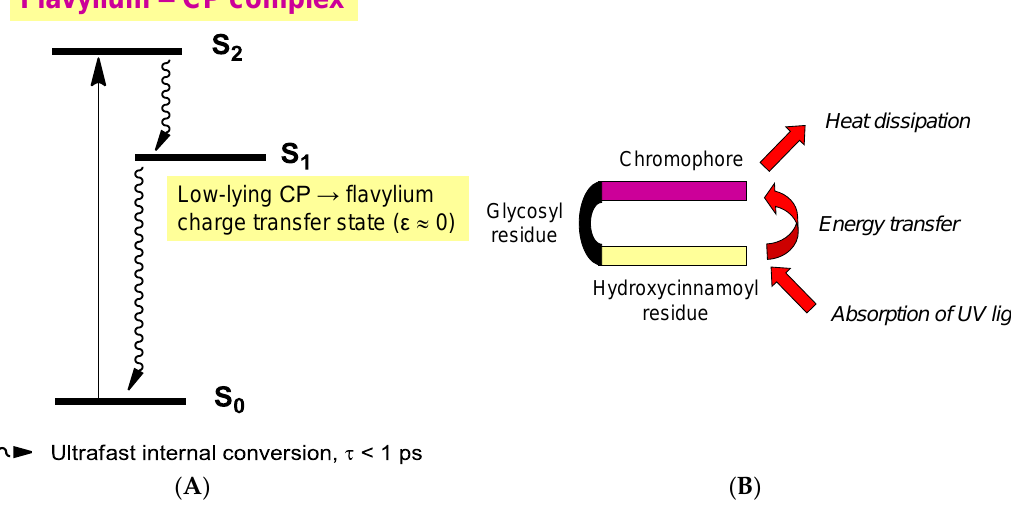
Figure 17. The influence of co-pigmentation on the fate of anthocyanins in the excited state. ( A ) Intermolecular co-pigmentation (from reference [57]). ( B ) Intramolecular co-pigmentation (from reference [58]).